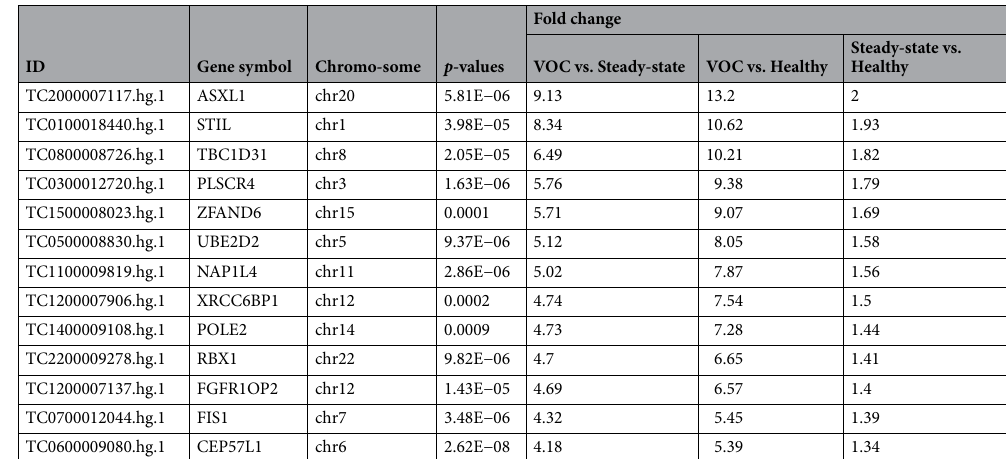
Table 3. Differentially regulated genes in SCD patients in VOC compared to SCD patients in steady-state.